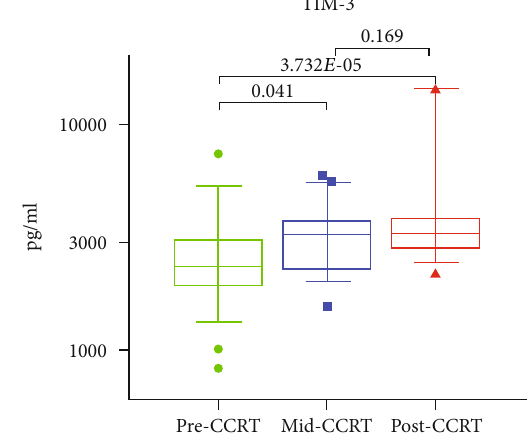
Figure 1: Signi fi cant changes in the sTIM-3 level during CCRT. The sTIM-3 levels were compared among pre-CCRT (green), mid-CCRT (blue), and post-CCRT (red), showing signi fi cant changes during CCRT. The P values were calculated using the Friedman test with Bonferroni ’ s